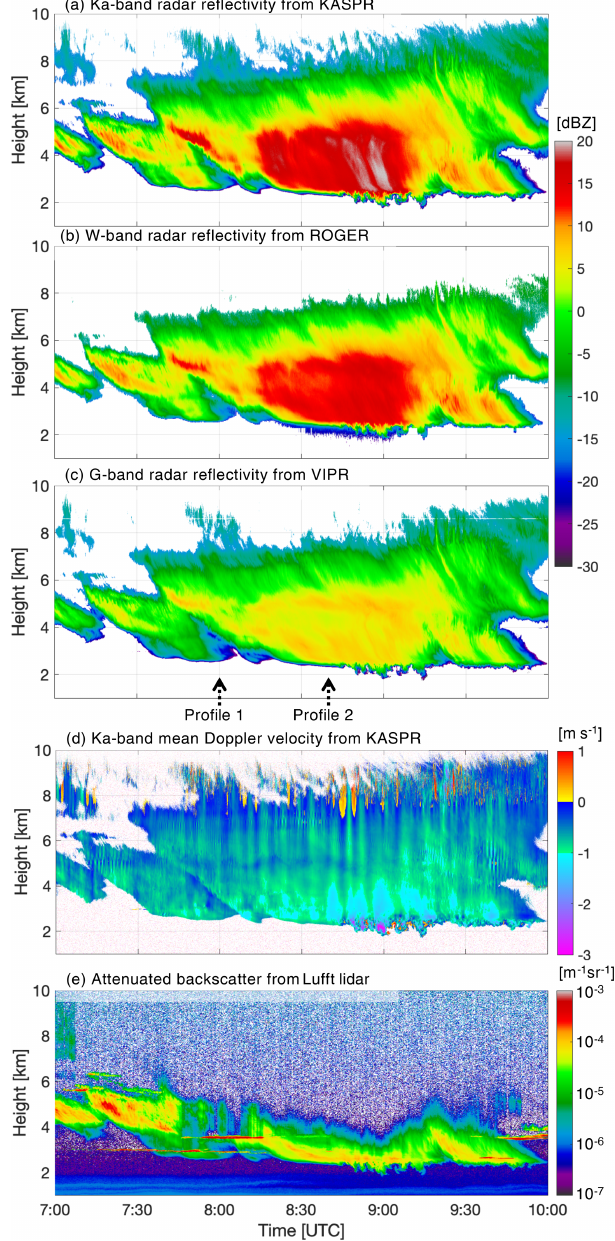
Figure 4. Time–height of radar reflectivity measured by (a) KASPR, (b) ROGER and (c) VIPR, between 07:00 and 10:00UTC on 25 February 2020. The arrows in panel (c) point to the time of the profiles displayed in Fig. 6. Also shown are time–height data of (d) mean Doppler velocity measured by KASPR (positive values indicate upward motion) and (e) attenuated backscatter measured by the Lufft lidar.